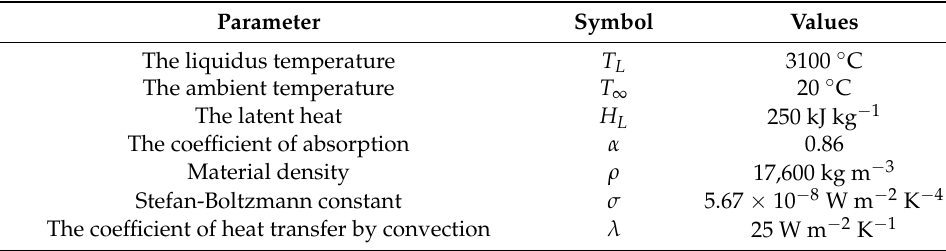
Table 2. Properties of tungsten alloy used in the simulation.